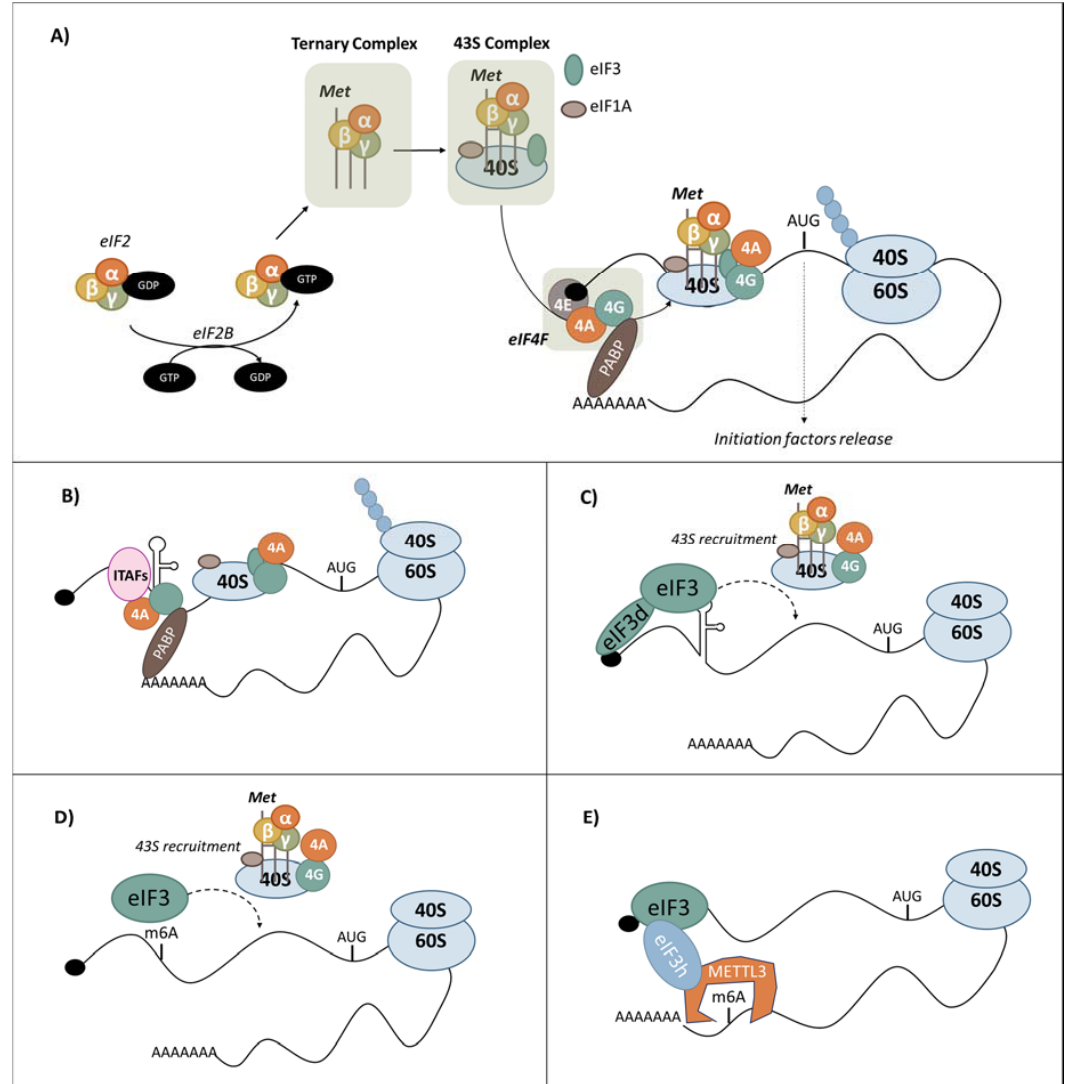
Figure 2. Currently known processes of translation initiation ( A) Cap ‐ dependent mechanism of translation. The eukaryotic initiation factor 2 (eIF2) ‐ GDP is recycled in eIF2 ‐ GTP by the enzyme translation. The eukaryotic initiation factor 2 (eIF2)-GDP is recycled in eIF2-GTP by the enzyme eIF2B. eIF2B. eIF2 ‐ GTP binds the methionine transfer RNA (Met ‐ tRNAi) in order to form the ternary eIF2-GTP binds the methionine transfer RNA (Met-tRNAi) in order to form the ternary complex which integrates the 43S complex comprising the 40S ribosome subunit, eukaryotic initiation factors (eIF3, eIF1 / 1A) and the ternary complex. 43S is recruited to the mRNA through the m7G cap by